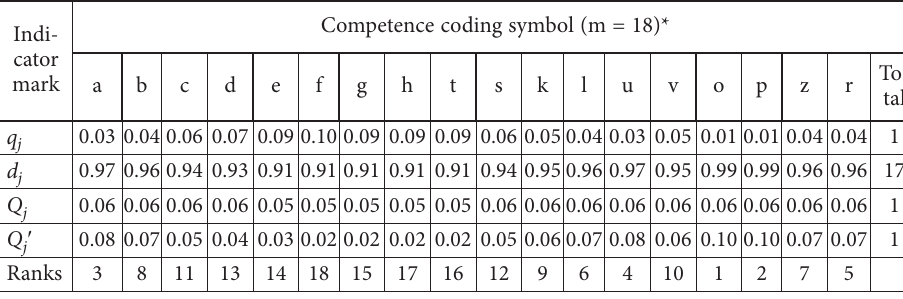
Table 5. The main indicators Q j of the important competencies for logistics forwarders (compiled by the authors) Competence coding symbol (m = 18)* Indi- cator mark a b c d e f g h t s k l u v o p z r q j